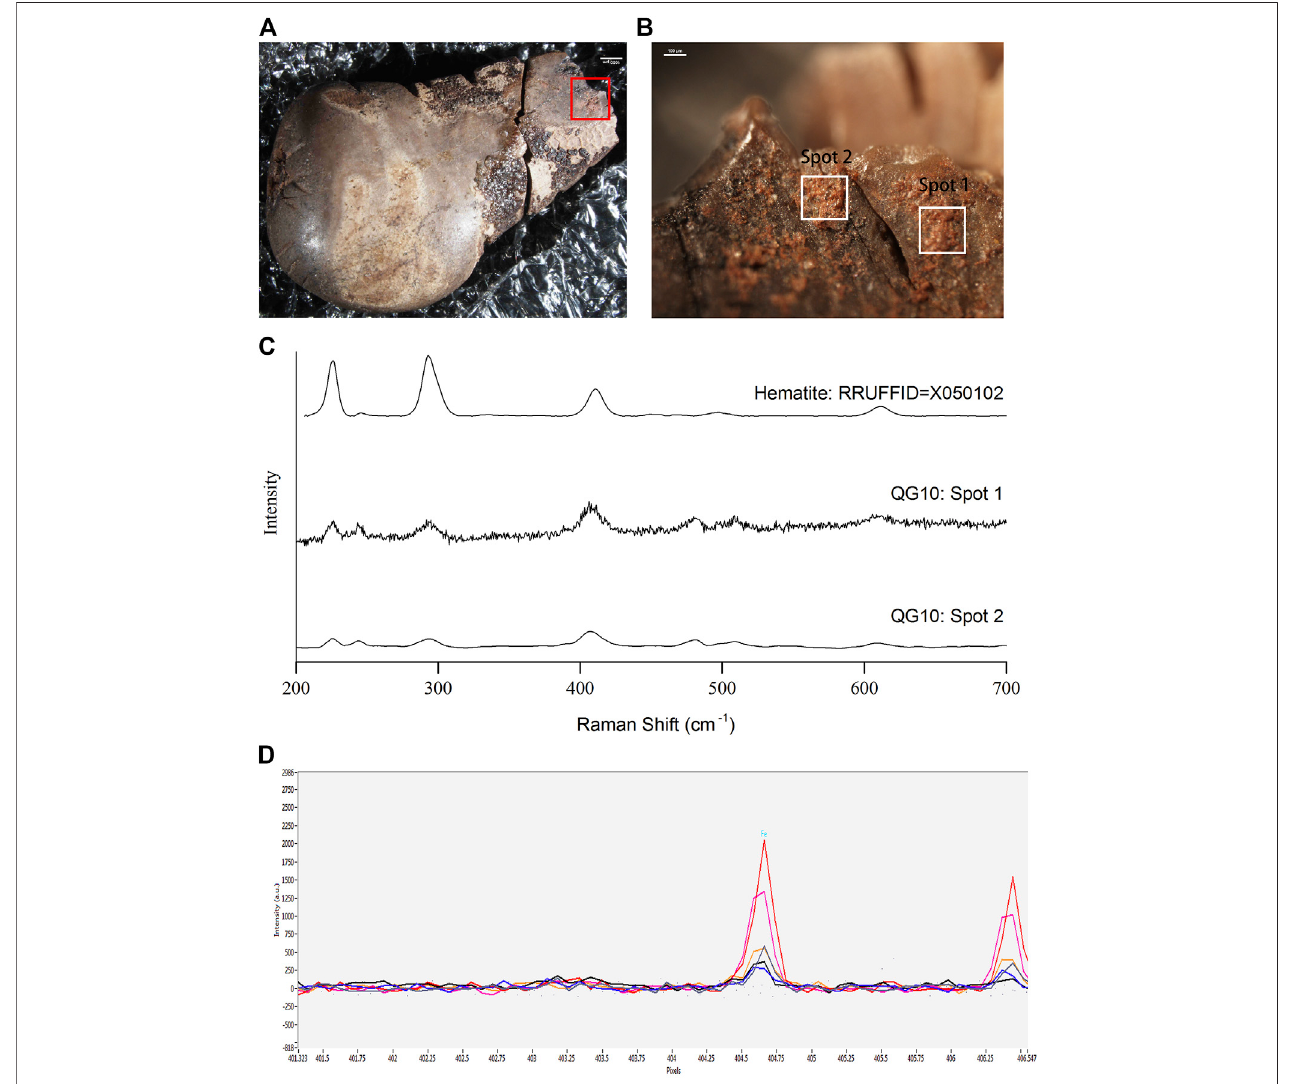
FIGURE 8 | (A) Location of the red residues on the tooth; (B) Areas in which red residues were sampled; (C) Results of the analysis of the red residues by Raman spectroscopy; (D) Results of the analysis of the red residues by LIBS (the pink and orange lines are for the two sampled spots of the red residues and other lines are for the sampled spots from areas seemingly lacking red residues). Scales: (A) 1,000 μ m, (B) 100 μ